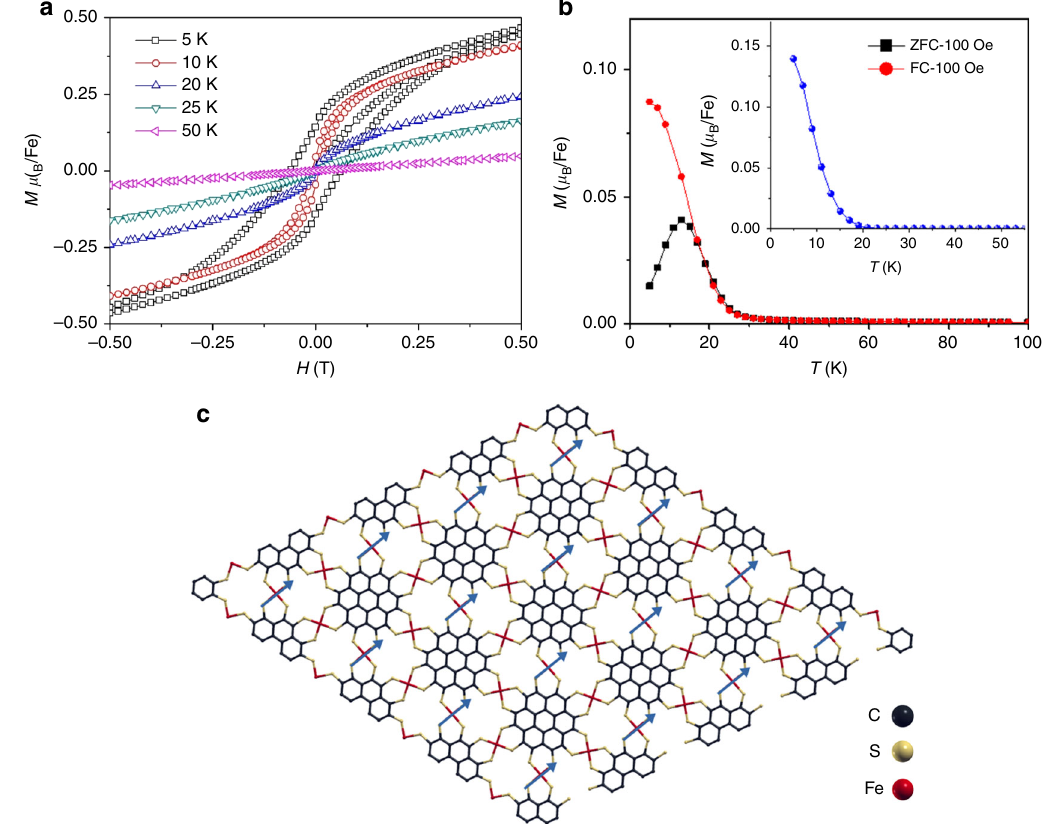
Fig. 5 Magnetic properties of PTC-Fe. a Magnetizations as functions of applied magnetic fi eld (H) measured at different temperatures. b Magnetization of PTC-Fe as a function of temperature measured in a 100 Oe fi eld under fi eld-cooled (FC) and zero- fi eld-cooled (ZFC) conditions. Inset: Temperature dependent remanent magnetization. c ferromagnetic ground state of PTC-Fe